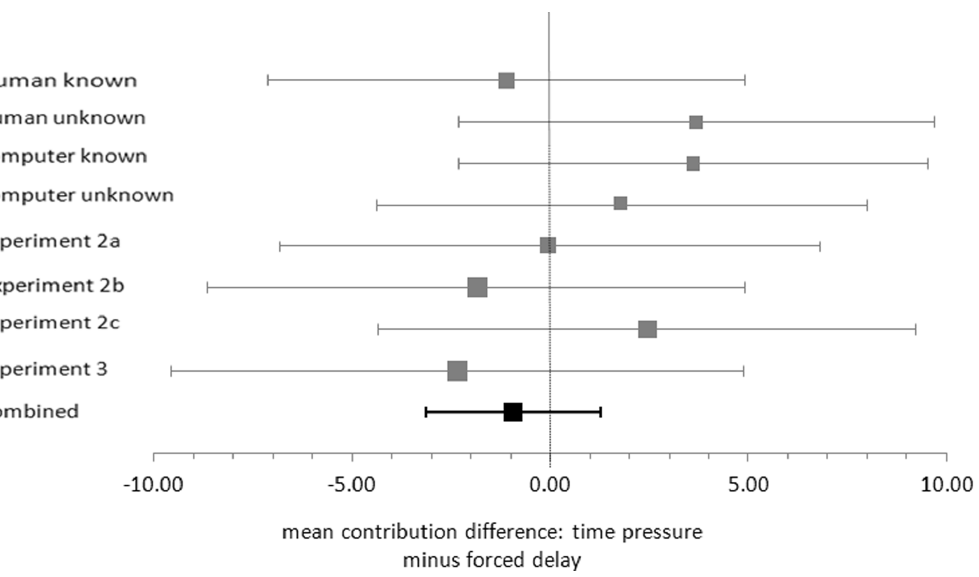
Figure 1. 95% Confidence intervals of the mean difference between the time-pressure and the forced-delay condition in Experiment 1 (human known to computer unknown), Experiment 2a, 2b and 2c, and Experiment 3. The combined effect from the random-effects model is presented in the 95% Confidence interval at the bottom of the figure.